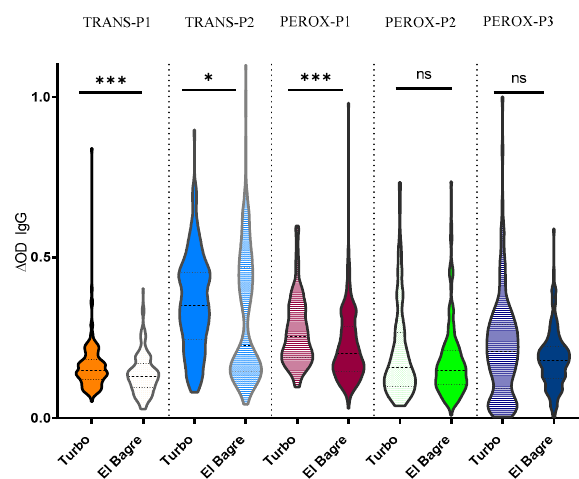
Figure 3. Schematic representation of the IgG antibody levels against each peptide by location Pairwise significance was tested with Mann-Whitney test with significance represented by stars ( p < 0.05 ( * = 0.01 to 0.05, ** = 0.001 to 0.01, and *** = 0.0001 to 0.001 ). ns denotes “not significant.” Int. J. Mol. Sci. 2020 , 21 , x FOR PEER REVIEW When comparing IgG antibody levels and malaria infection status, we found that samples with active malaria infection had significantly higher antibody levels than the controls for all the peptides, with the exception of the IgG levels against PEROX-P1 in Turbo ( p = 0.7614) and PEROX-P2 in El Bagre ( p = 0.5343) (Figure 4).